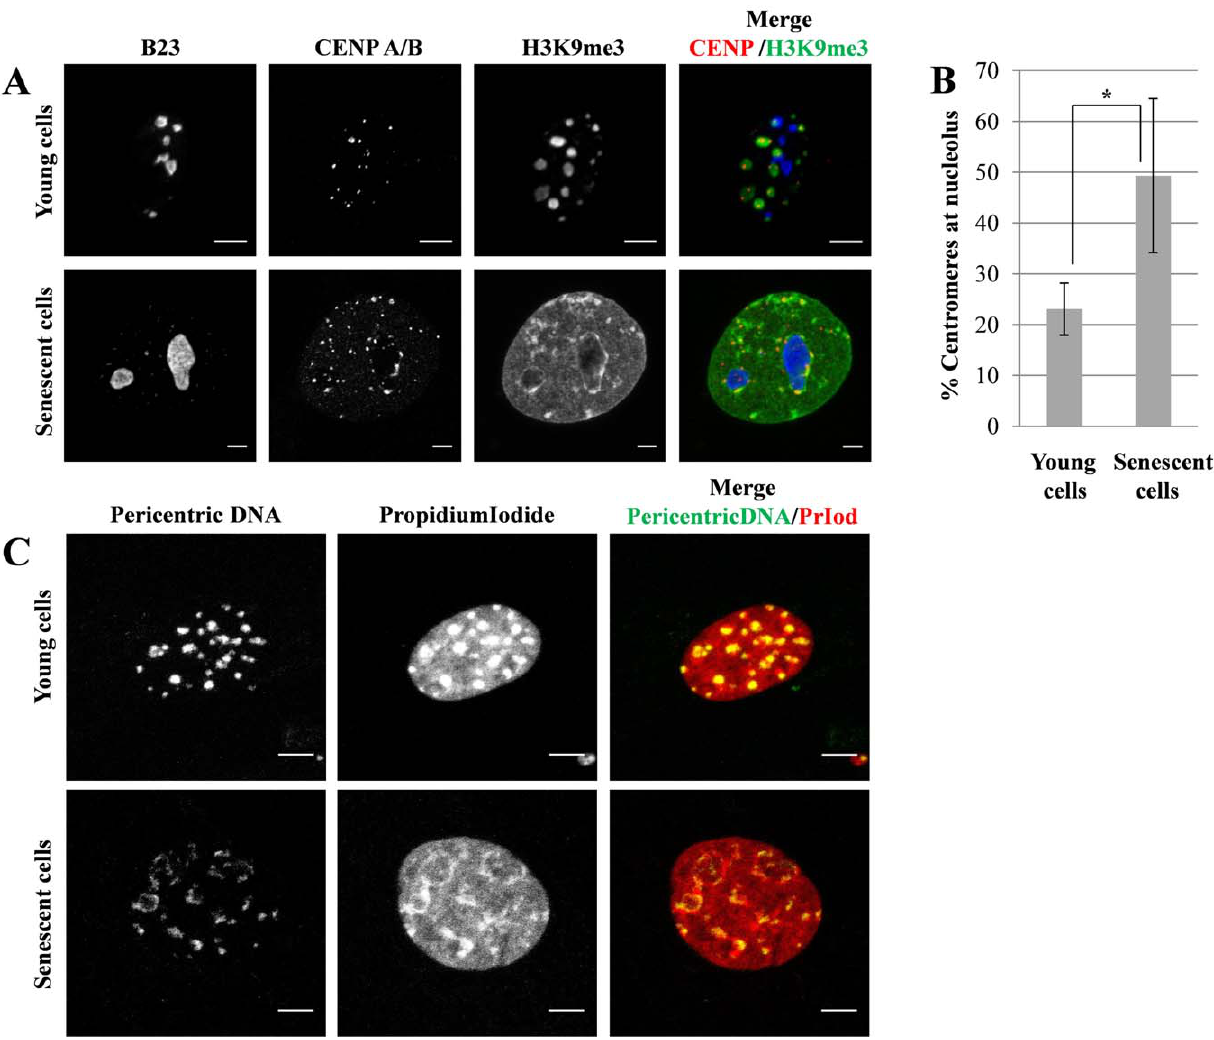
Figure 2. Centromeres and pericentric domains in nuclei of senescent bovine fibroblasts. ( A ) Confluent young primary bovine fibroblasts and cells at late passages were immunostained to detect CENP (red), H3K9me3 (green) and nucleoli (B23; blue). Compare the distribution of condensed heterochromatin (H3K9me3 distribution) in young cells and the distribution of dispersed ring- or ribbon-like heterochromatin that associates to nucleoli in senescent cells. Scale bars: 5 m m. ( B ) Quantitation of nucleoli-associated centromeres in senescent (n=68) and young cells (n=215). ( C ) Confluent primary young bovine fibroblasts (upper panel) and senescent cells (lower panel) labelled by fluorescent in situ hybridization with BAC231G08 (green) specific to pericentric regions of bovine autosomes and counterstained with Propidium iodide (red). Images are obtained from confocal Z-stack projections. Scale bars: 5 m m.